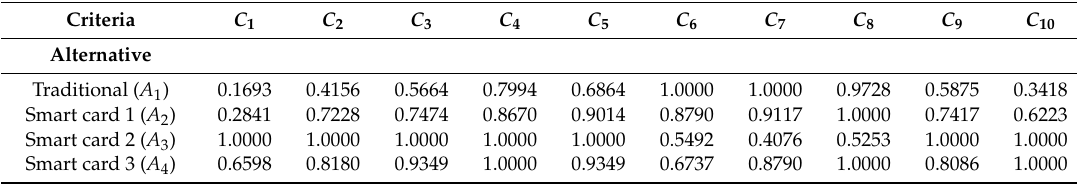
Table 5. Normalized decision matrix.